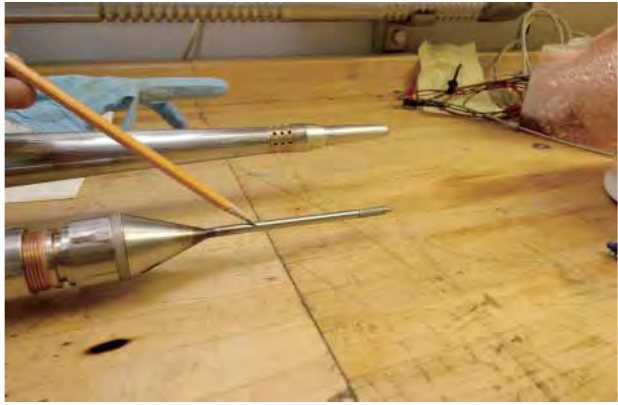
Figure 6. Temperature Two Pressure probe (T2P, foreground) and Davis- Villinger Temperature-Pressure Probe (DVTPP, background). Both tools measure formation pressure by being forced into formation by drill string.